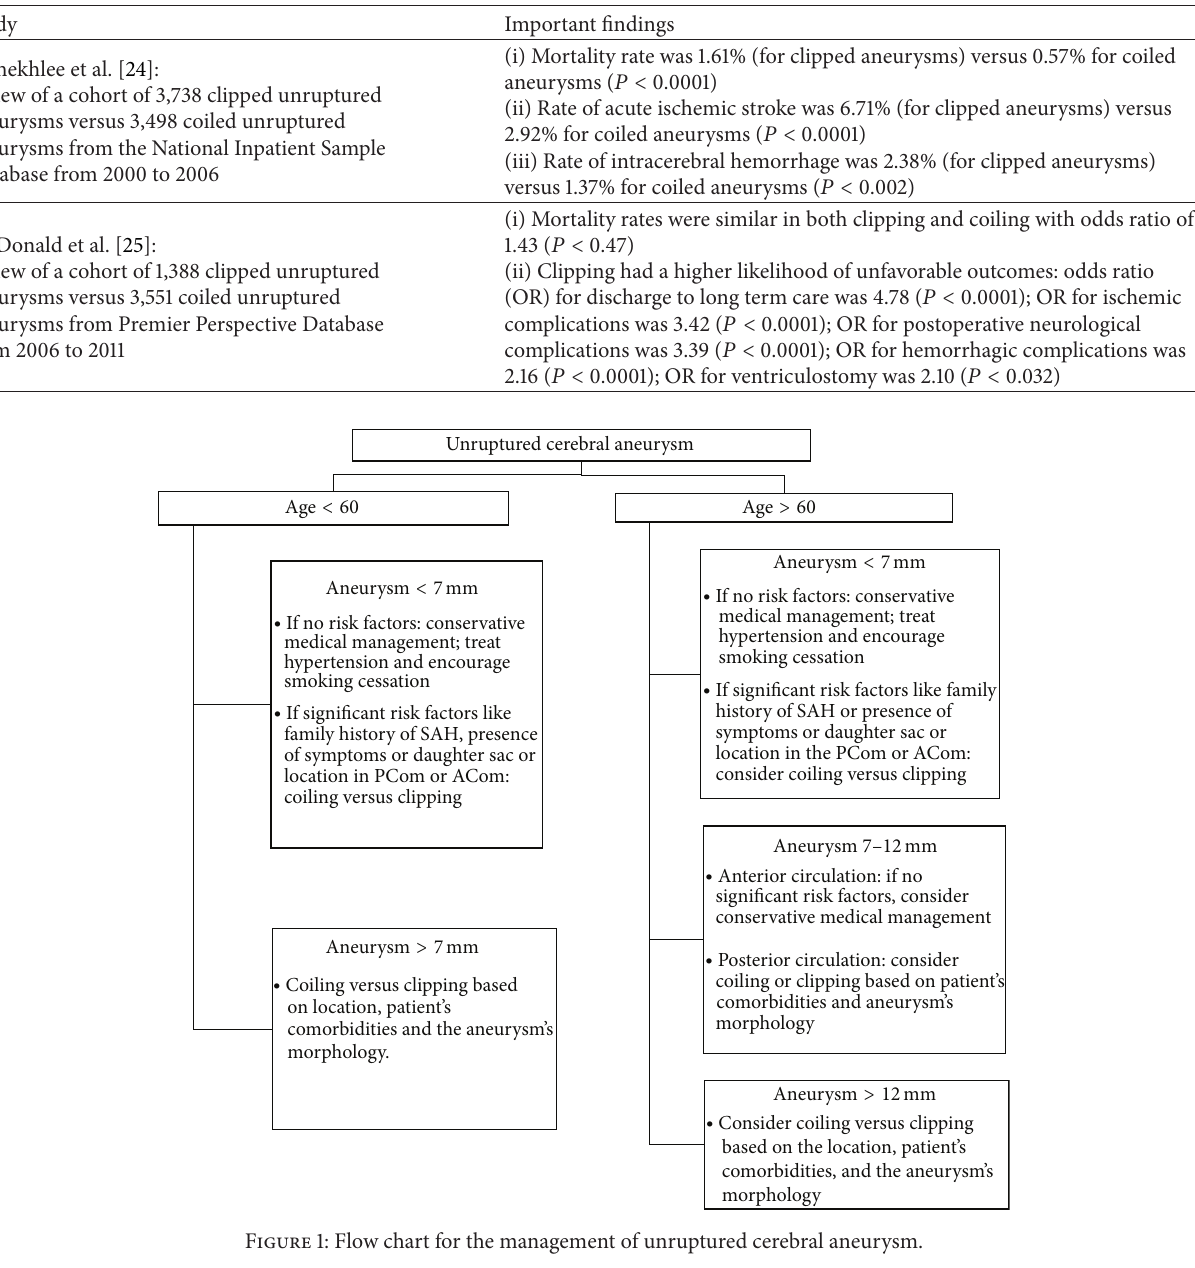
Table 5: Summary of large studies evaluating the treatment risk of unruptured cerebral aneurysms.